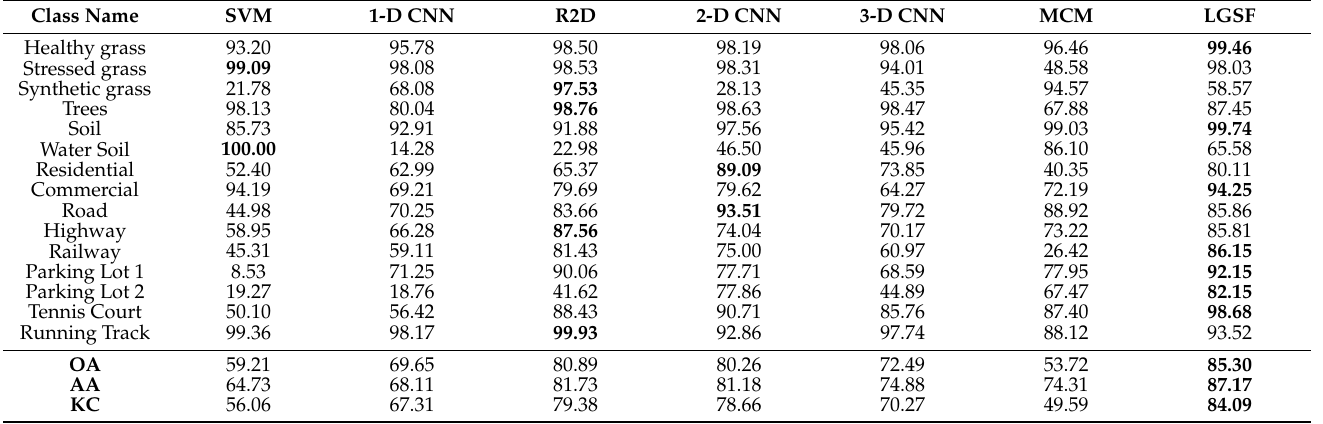
Table 5. Classification results of different methods on the Houston 2013 dataset. (shown in